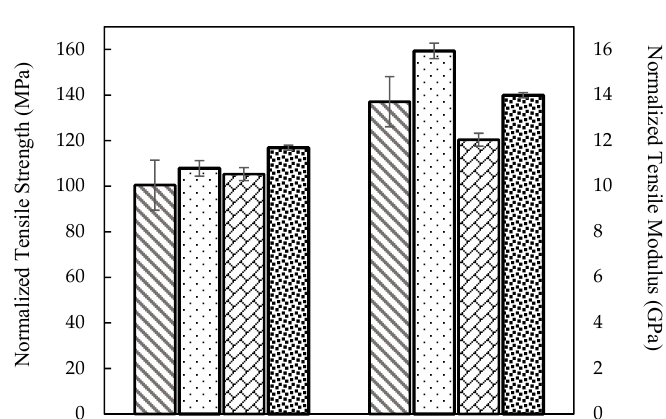
Figure 5. Normalized tensile strength and tensile modulus of untreated and treated flax/VE composites.